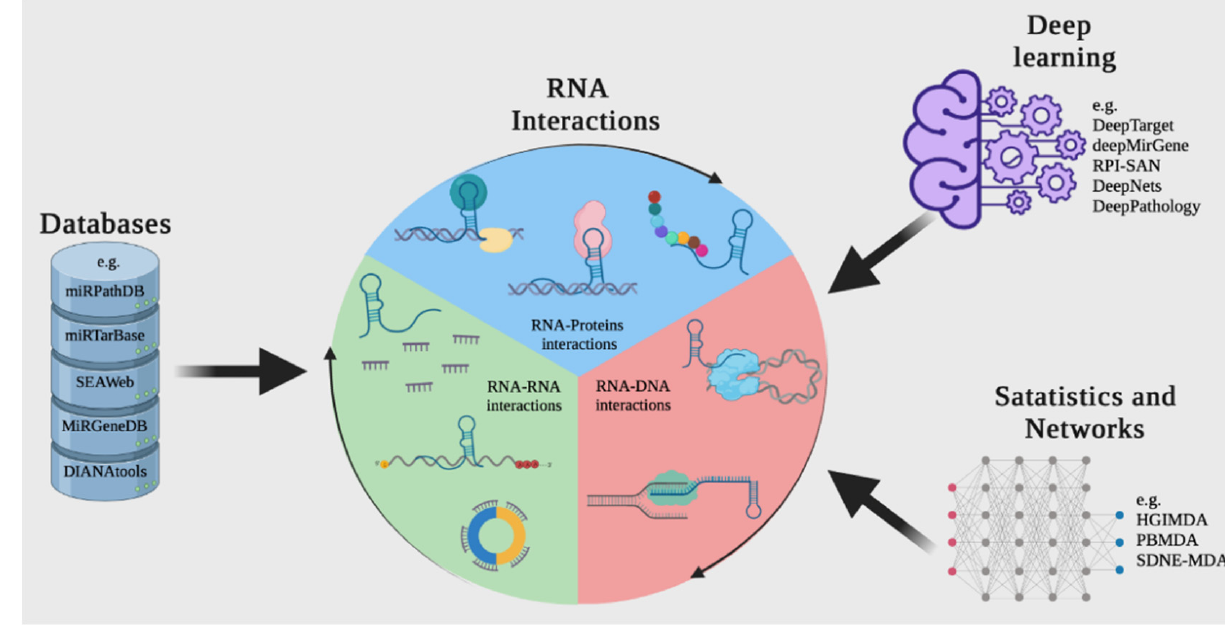
Figure 4. A computational approach for discovering or predicting RNA interactions among different biomolecules. The first strategy is to search in web tools or RNA databases such as miRTarBase. Another way to discover RNA interactions is to use resources based on deep learning and other machine learning-based tools, such as DeepTarget and deepMirGene. Finally, different mathematical and network theory methods can be used to research RNA interactions.